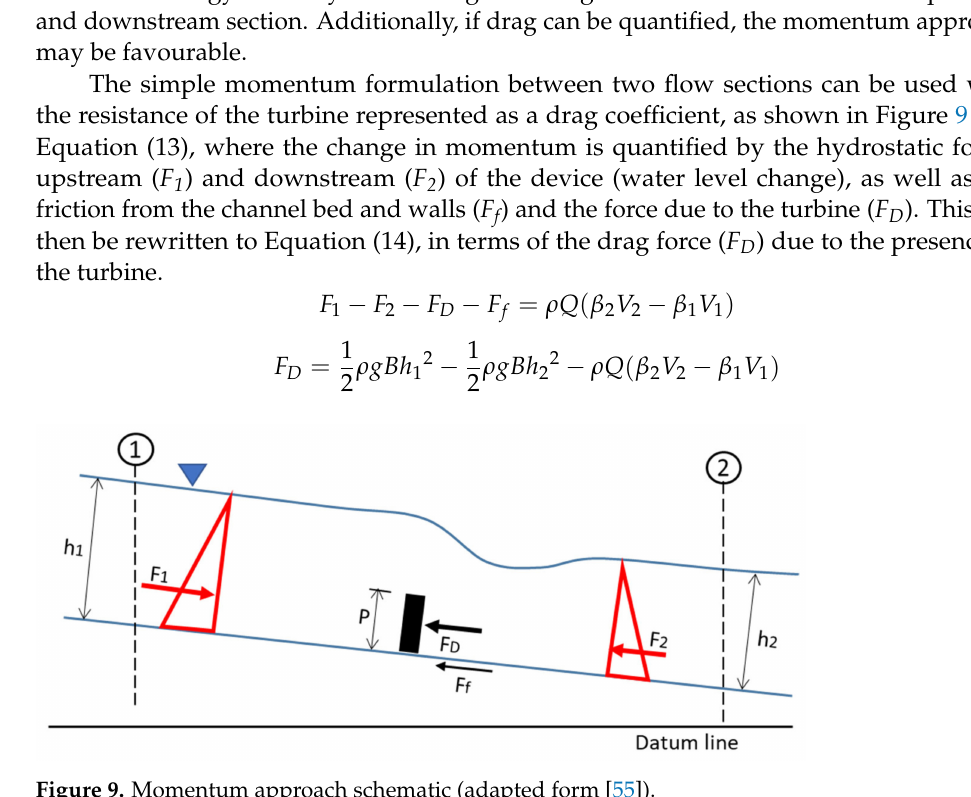
Figure 9. Momentum approach schematic (adapted form